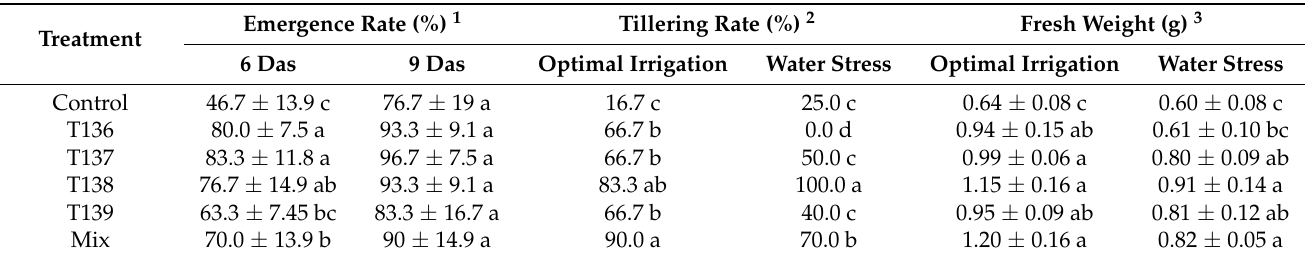
Table 5. Effect of five Trichoderma treatments ( T. harzianum T136, T. simmonsii T137, T. afroharzianum T138, T. harzianum T139, and a mixture with these four strains) on emergence, tillering, and fresh weight of Basilio wheat grown in a greenhouse under optimal irrigation and water stress (irrigation was removed for 2.5 weeks when plants were 21 days old) conditions.